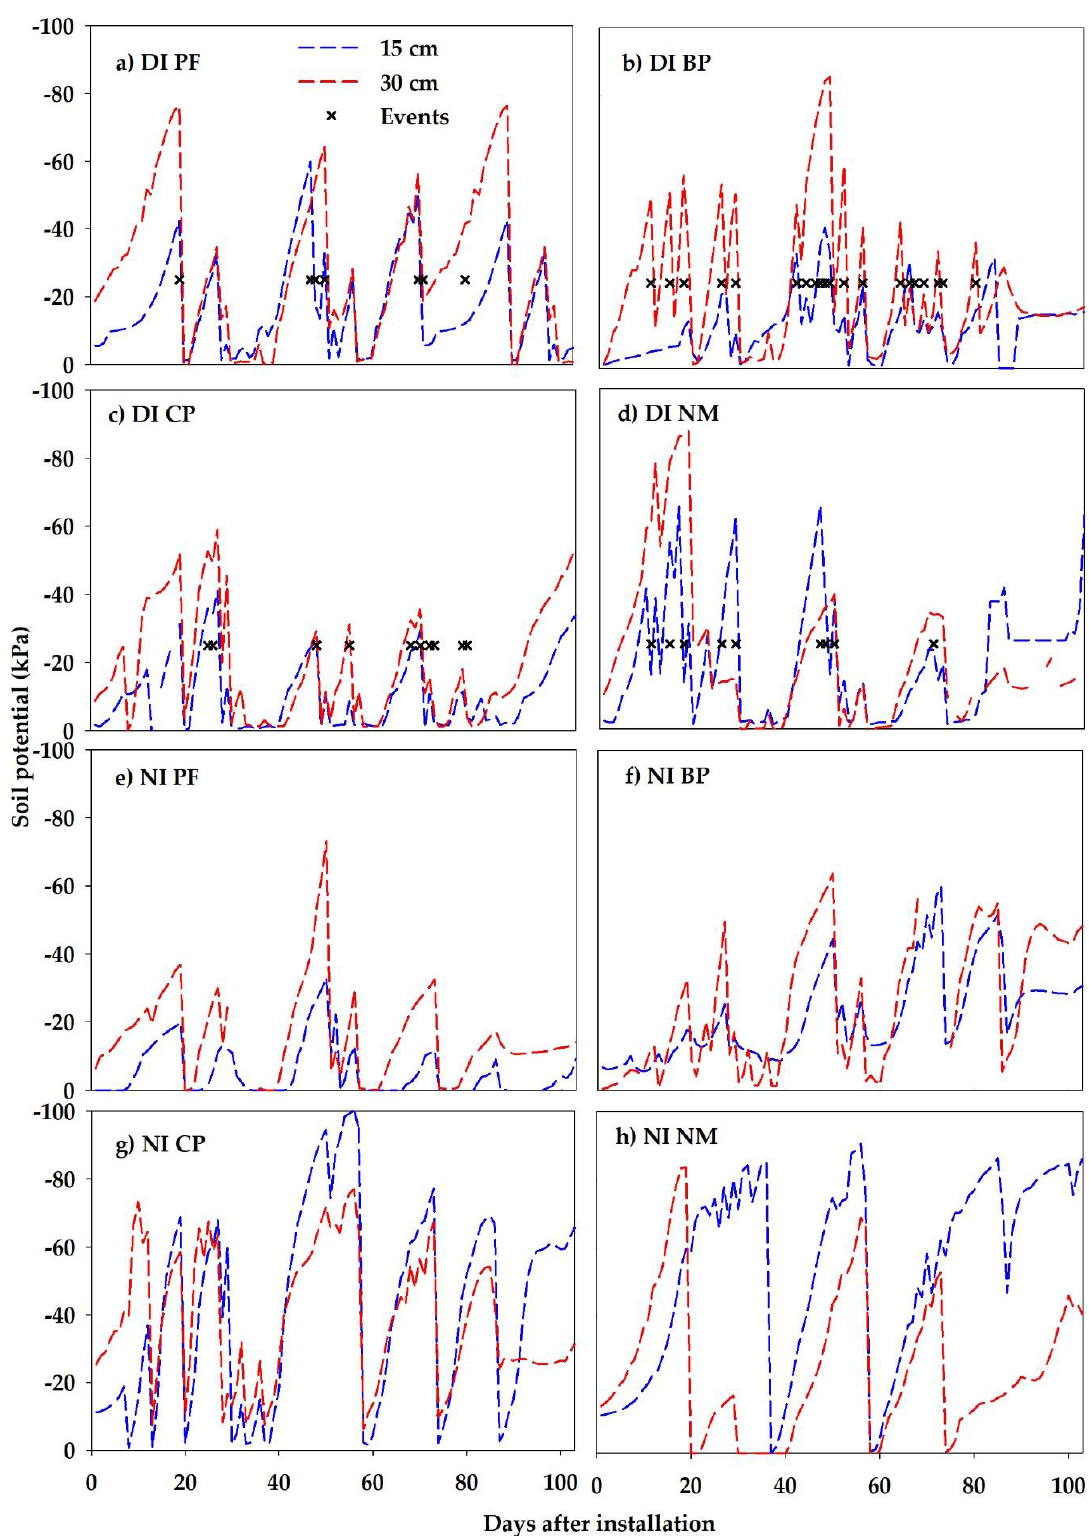
Figure 4. Daily average soil matric potential (09:00 am) at 15 and 30 cm deep in tomato plots during 2020 field experiment under drip irrigation (DI) treatment with ( a ) landscape fabric mulch (DI PF), ( b ) black plastic mulch (DI BP), ( c ) clear plastic mulch (DI CP), ( d ) no mulch (DI NM), and no irrigation treatment (NI) with ( e ) landscape fabric mulch (NI PF), ( f ) black plastic mulch (NI BP), ( g ) clear plastic mulch (NI CP), and ( h ) no mulch (NI NM).